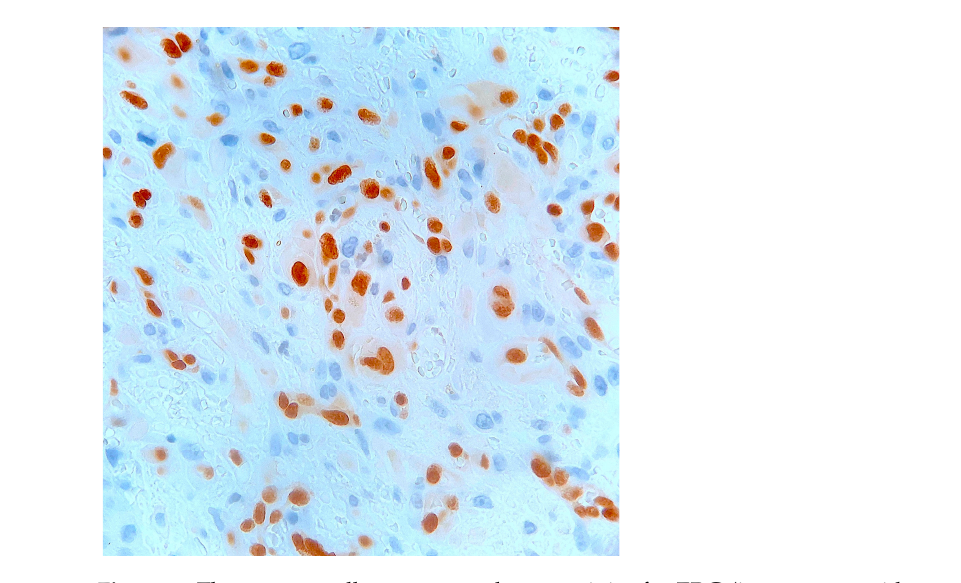
Figure 7. The tumour cells express CD34 (immunoperoxidase revealed with diaminobenzidine).